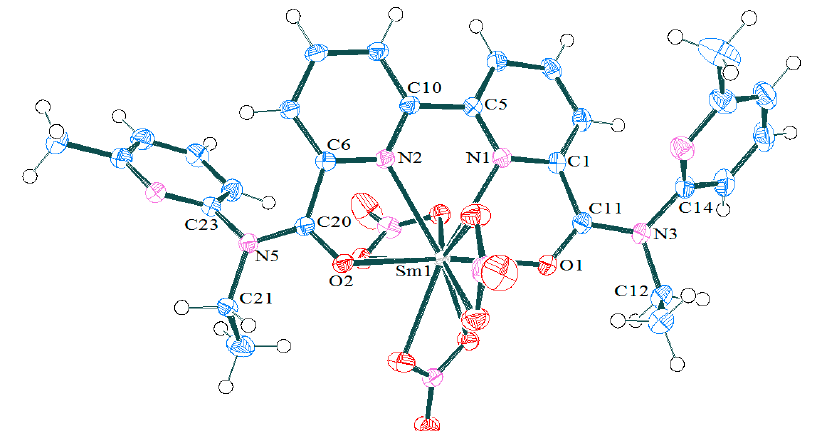
Figure 2. Molecular structure of Sm( 3c )(NO 3 ) 3 showing the atom numbering scheme. Displacement ellipsoids are drawn at the 50% probability level, and H atoms are shown as small spheres of arbitrary radius.